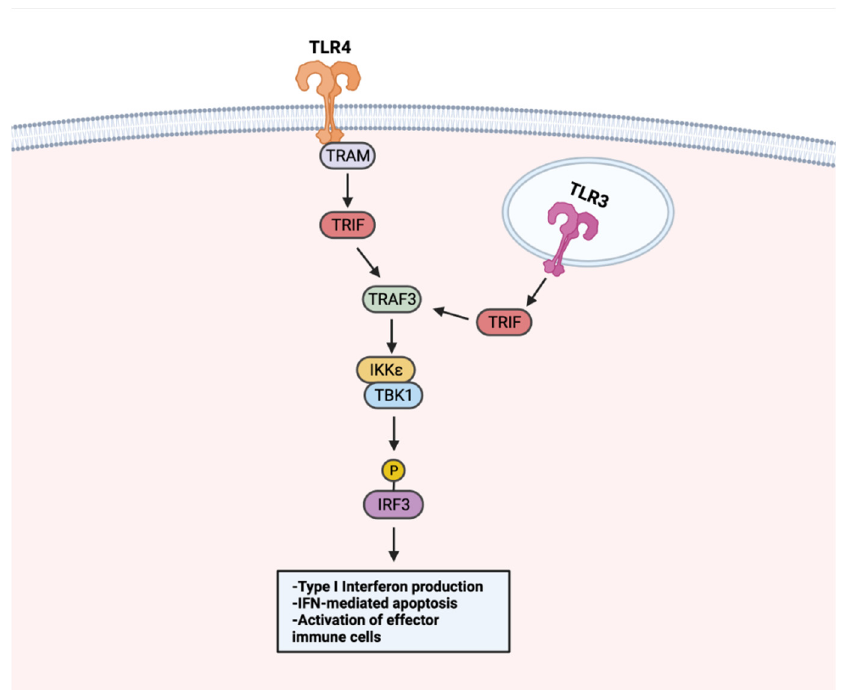
Figure 5. TLR–IFN signaling in anti-tumor responses. TLRs use a MyD88-independent pathway